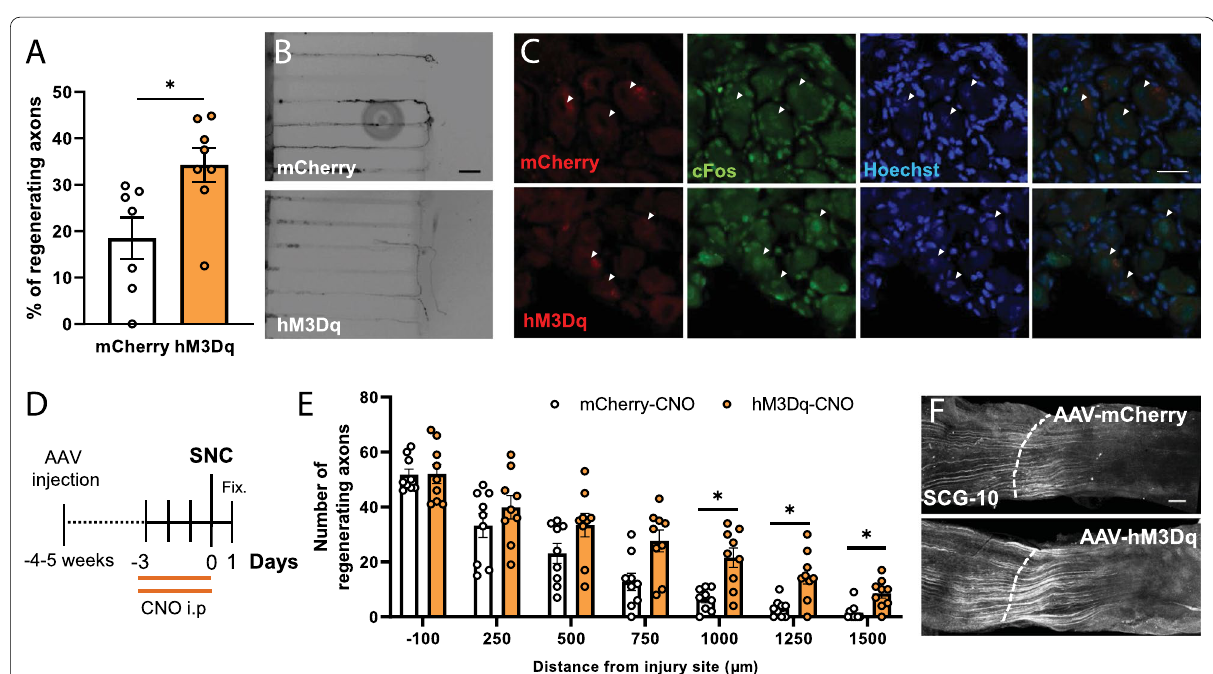
Fig. 2 Chemogenetic stimulation induced PNS regeneration. A Chemogenetically stimulating DRG neurons in vitro 6 h after axotomy resulted in regeneration promotion. Data are expressed as the mean percentage of infected regenerating axons compared to the total of infected axons reaching the axonal compartment s.e.m (n 7–8 axonal compartments). *p < 0.05 denotes significant differences in Student’s t‑Test. ± = B Representative images of hM3Dq/mCherry + axons. Scale bar: 50 μm. C c‑Fos nuclear staining is observed in hM3Dq infected DRG neurons (white arrows) 1 h after CNO injection, but not in mCherry + DRG neurons after the same treatment. Scale bar: 25 µm. D Schematic timeline of the experiment. E The number of regenerating sensory axons (SCG‑10 + ) in stimulated nerves (hM3Dq‑CNO) is increased in all assessed distances compared to the non‑stimulated (mCherry‑CNO) reaching statistical significance in long distances. Data are expressed as mean s.e.m. at each ± distance from the injury site (n 9 sciatic nerves). *p < 0.05 denotes significant differences in ANOVA followed by Bonferroni test. F SCG‑10 = immunostaining of mCherry or hM3Dq infected sciatic nerves 24 h after SNC. Dotted lines indicate the injury site. Scale bar: 200